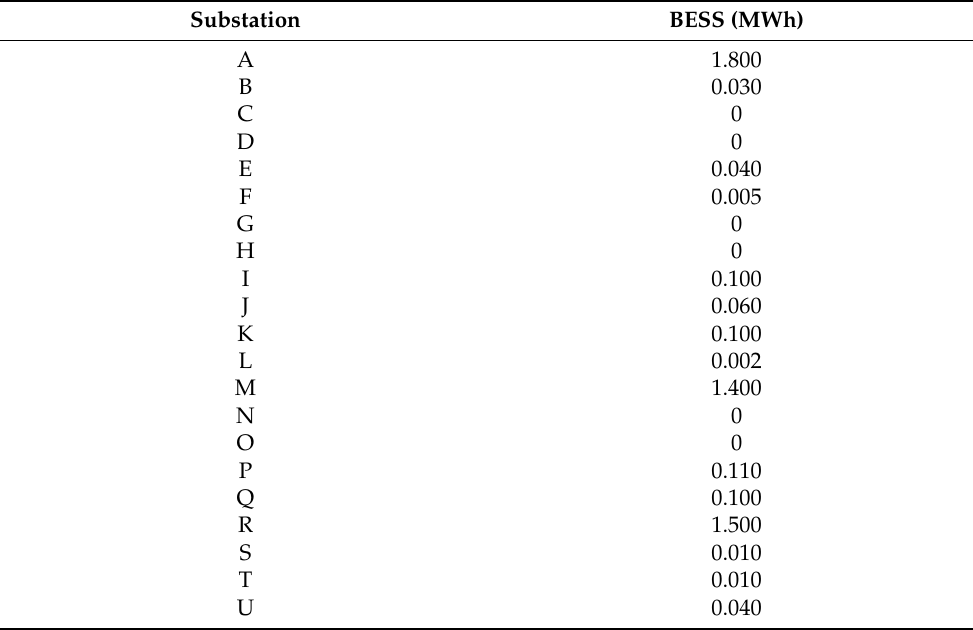
Table 1. Optimal sizing of decentralized utility-scale BESS using the